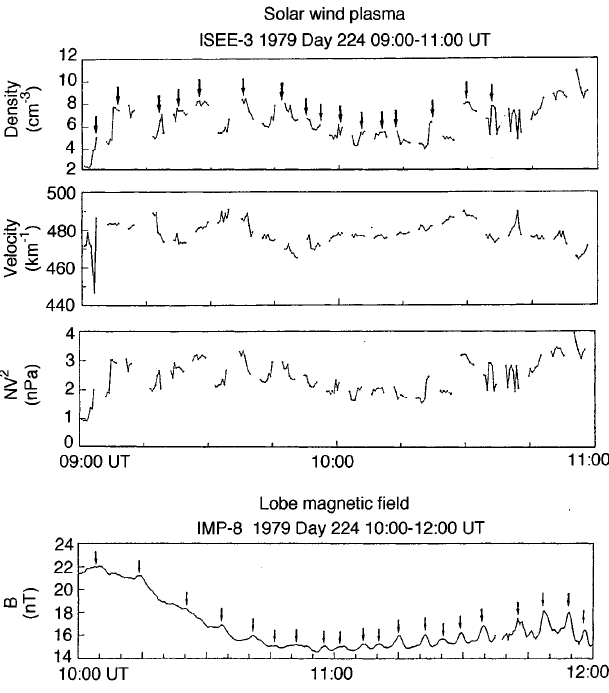
Fig. 4. An example of nearly identical Pc 5 pulsations observed in the solar wind plasma bulk parameters by ISEE 3 ( top ) and in the magnetotail magnetic field by IMP-8 ( bottom ) (adapted from Fig. 13 of Sarafopoulos, 1995). The solar wind and tail data are shifted by 1 h from each other to incorporate the solar wind flow from the ISEE 3 position (about 240 R upstream) to the E